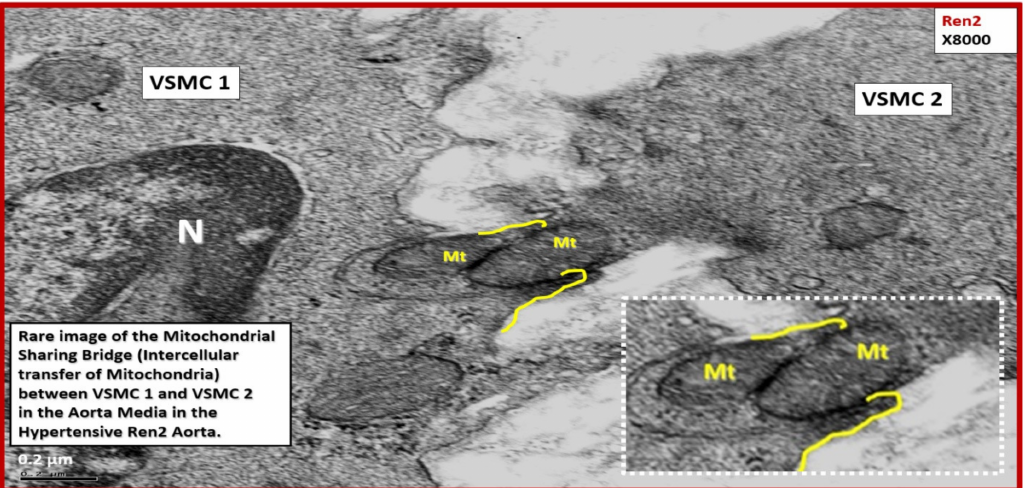
Figure 21. Rare image depicting intercellular mitochondria (Mt) transfer from one vascular smooth muscle cell to another in the descending aorta of the insulin resistant, impaired glucose tolerant, hypertensive 12-week-old Ren2 rat model. This image depicts the rare intercellular transfer of mitochondria between vascular smooth muscle cells (VSMC 1) and VSMC 2. Note the exploded image in the lower-right outlined by white dashed lines. It is intriguing to think that in the stressed media of the Ren2 model of hypertension that a VSMC may be capable of transferring its Mt from a healthy VSMC to one that has extensive aberrant Mt as in the previous image in Figure 20 from panel A to panel B in order to maintain VSMC homeostasis. This image is from the same experiment as in reference [66]; however, it has not been previously published. Magnification × 8000; scale bar = 0.2 µ m. N = nucleus .